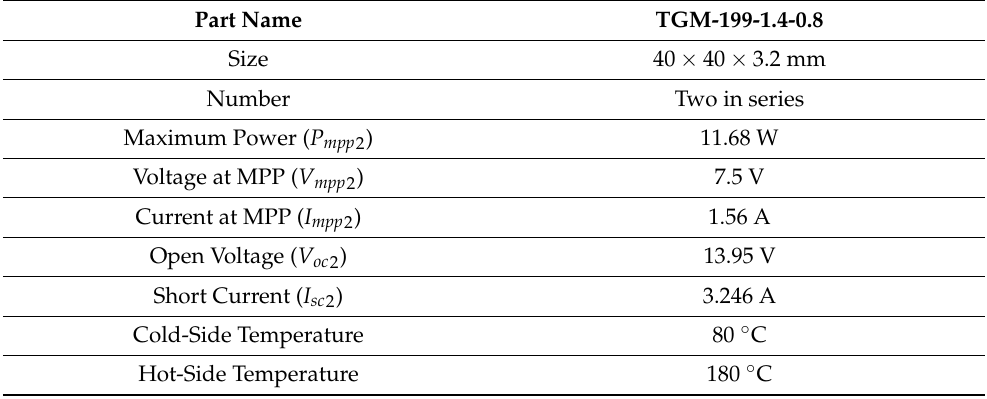
Table 2. Specifications for the second thermoelectric module.